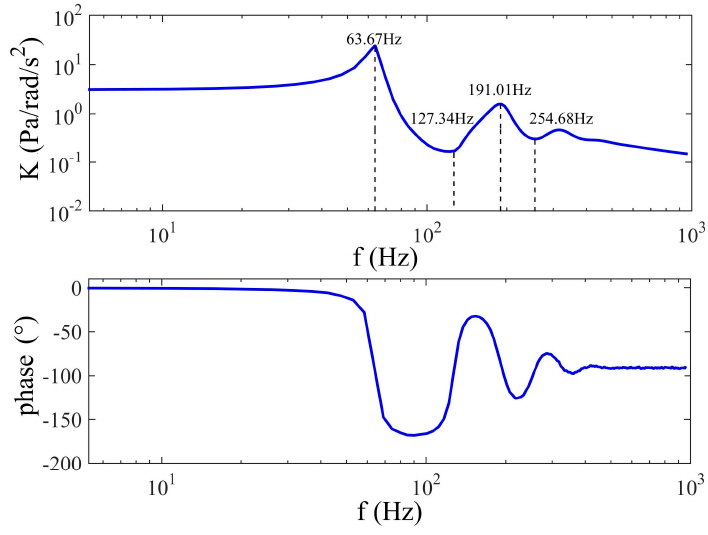
Figure 8. Theoretical frequency response of the fluidic system.